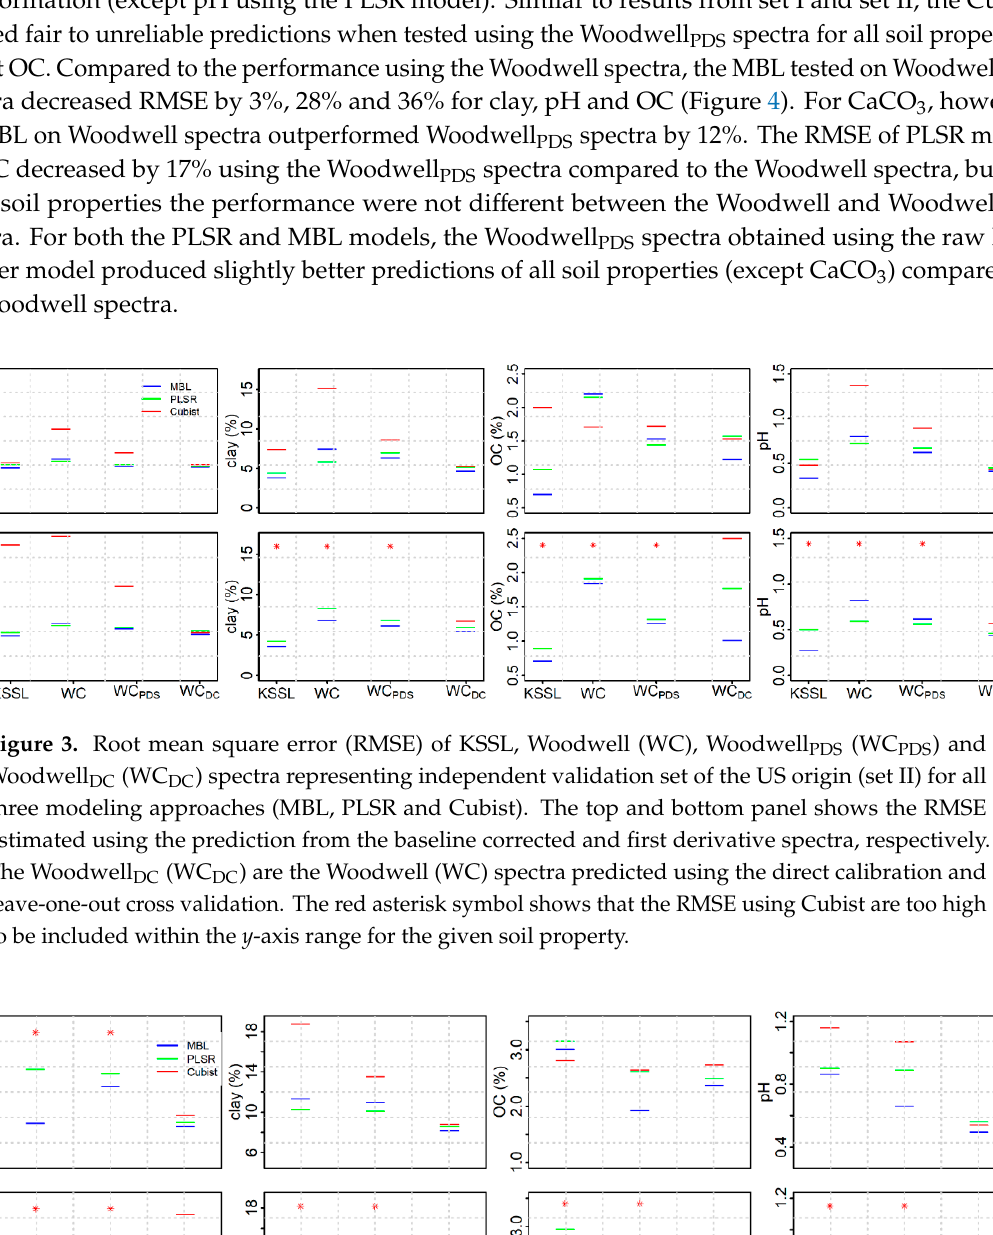
bottom panel shows the RMSE estimated using the prediction from the baseline corrected and first derivative spectra, respectively. The Woodwell DC are the Woodwell spectra predicted using the direct calibration and leave-one-out cross validation. The red asterisk symbol shows that the RMSE using Cubist are too high to be included within the y -axis range for the given soil property.